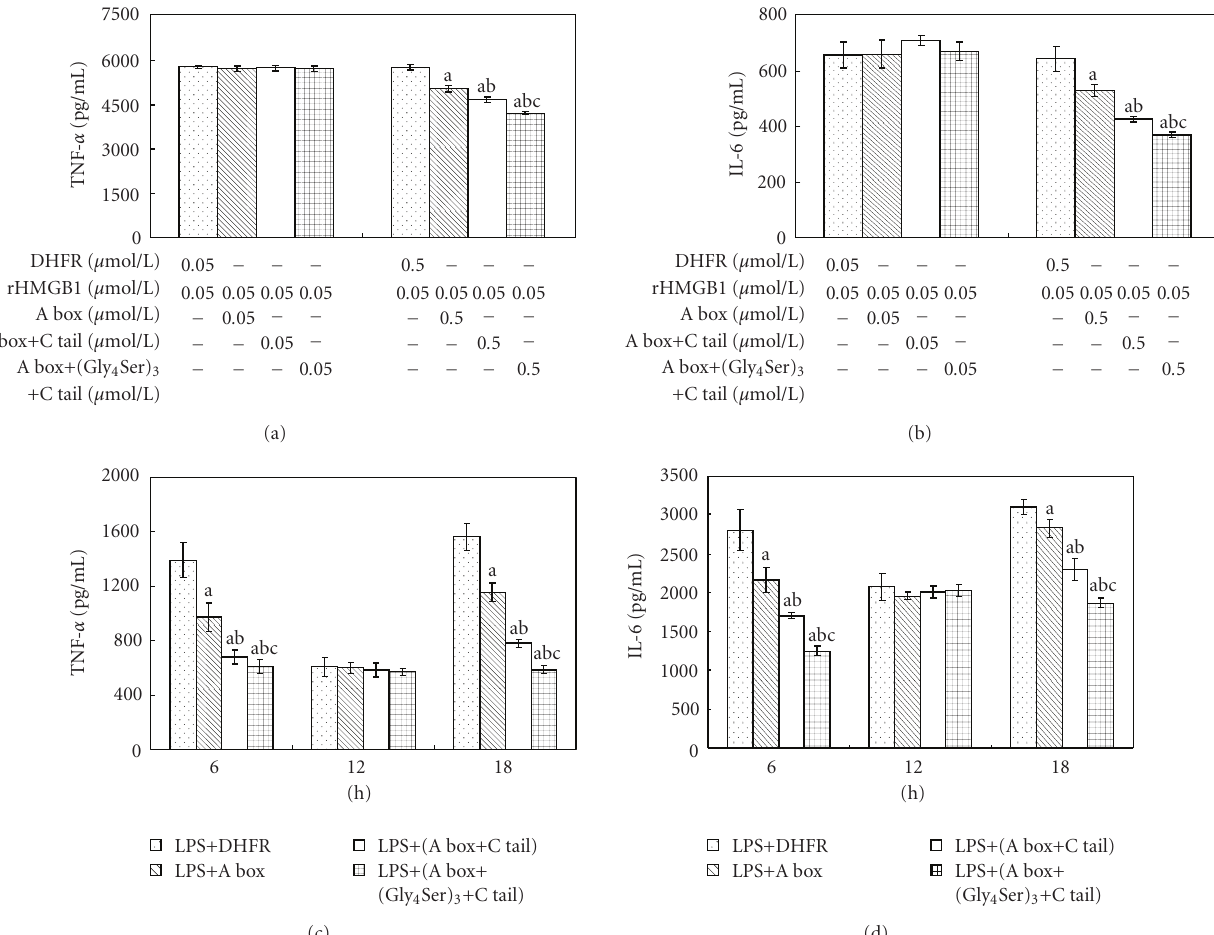
Figure 3: The C tail-fused A box could suppress TNF- α and IL-6 release in vitro and in vivo more e ffi ciently than A box alone. (a) and (b) The C tail-fused A box could inhibit HMGB1-induced TNF- α and IL-6 release in vitro more e ffi ciently than A box alone. THP-1 cells in 96-well plates were treated with rHMGB1 (0.05 μ mol/L) and various concentrations of A box, A box+C tail, A box+(Gly 4 Ser) 3 +C tail, or DHFR control proteins (as indicated) for 6 hours in the presence of polymyxin B (6 units per pg of LPS). The levels of TNF- α and IL-6 in the cultured supernatants were measured by ELISA. Each experiment was performed in triplicate and repeated three times. (c) and (d) The C tail-fused A box could reduce serum TNF- α and IL-6 levels in the mice subjected to endotoxemia more e ffi ciently than A box alone. BALB/c mice (5 mice/group), subjected to LD 75 doses of LPS (15mg/kg), were treated at 0 and 12 hours after LPS injection with A box, A box+C tail, A box+(Gly 4 Ser) 3 +C tail or DHFR control proteins (40 nmol per mouse). The sera of the mice were obtained from orbital blood 6, 12, and 18 hours after LPS injection respectively. The serum levels of TNF- α and IL-6 were determined by ELISA. Each experiment was repeated three times. The results showed that the A box alone and the two C tail-fused A box proteins could significantly inhibit TNF- α and IL-6 release in vitro and in vivo. The A box+(Gly 4 Ser) 3 +C tail fusion protein had the most e ffi cient inhibitory activity, followed by the A box+C tail fusion protein and the A box. Data shown are the means ± standard deviation and were analyzed with one-way ANOVA. a: P < . 05 versus DHFR; b: P < . 05 versus A box; c: P < . 05 versus A box+C